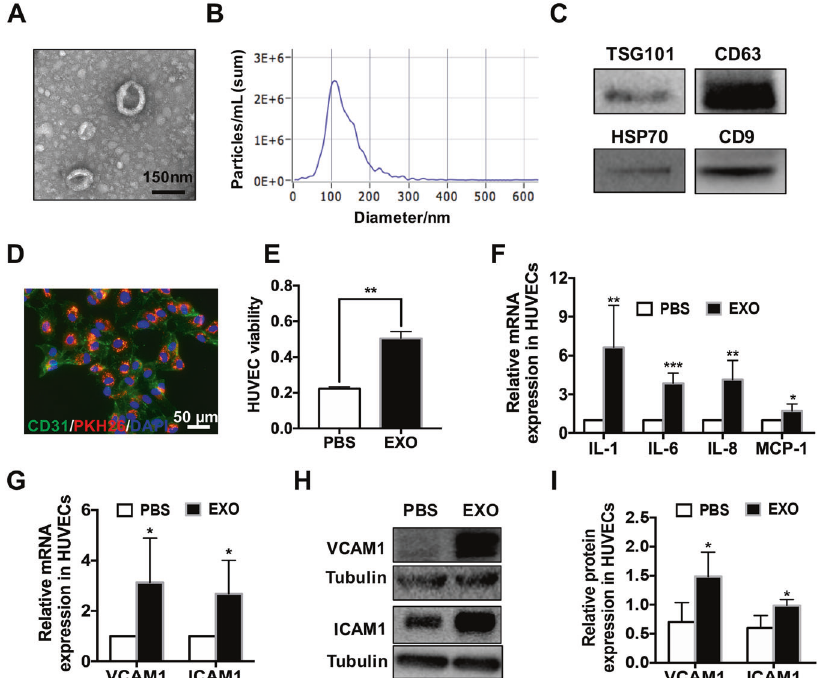
Fig. 1 Exosomes derived from WERI-Rb1 cells mediate the activity of HUVECs. A Representative TEM images of WERI-Rb1 exosomes. The diameter of the vesicles was approximately 50 – 150 nm. Bar = 150 nm. B Nanoparticle tracking analysis (NTA) indicated that the average size and number of exosomes (97.7% of exosomes had a size of 108.0 nm). C Western blot analysis of the different protein markers (HSP70, CD9, TSG101, CD63) of exosomes collected from the WERI-Rb1 cells. D Exosomes labeled with PKH26 were swallowed by HUVECs (PKH26, red; CD31, green; DAPI, blue). Bar = 50 μ m. E CCK-8 assays showed that the viability of the HUVECs was markedly elevated by the exosomes ( n = 3, ** P < 0.01). F Real-time PCR analysis of IL-1, IL-6, IL-8 and MCP-1 expression in the HUVECs incubated with the exosomes derived from WERI- Rb1 cells for 24 h. ( n = 6, * P < 0.05, ** P < 0.01, *** P < 0.001) according to two-tailed Student ’ s t test. G Real-time PCR analysis of VCAM1 and ICAM1 expression in the HUVECs incubated with the exosomes derived from WERI-Rb1 cells for 24 h ( n = 6, * P < 0.05). H Western blot analysis indicating that exosome treatment upregulated VCAM1 and ICAM1 expression in the HUVECs. I Relative quanti fi cation of protein expression in HUVECs was performed by densitometry ( n = 4, * P <